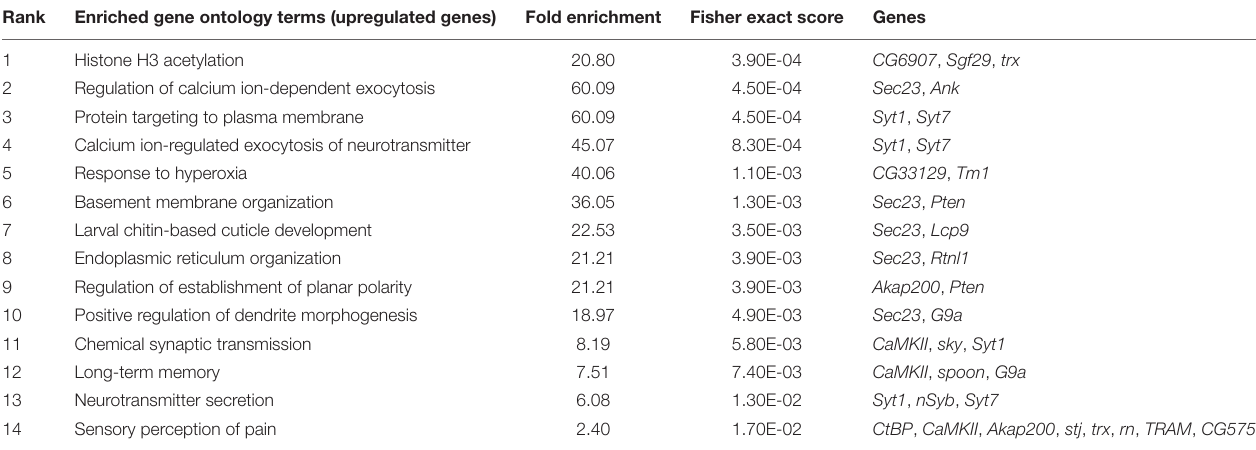
TABLE 2 | Overrepresented gene ontology (GO) annotations for alcohol-upregulated